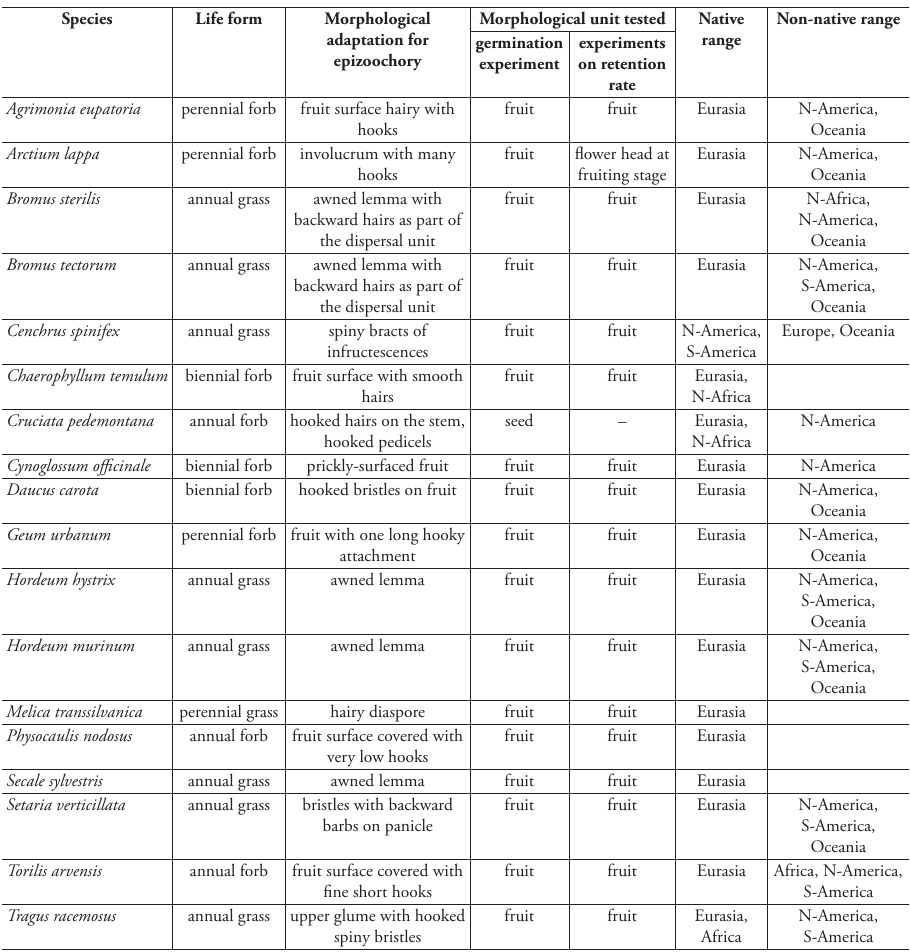
Table 1. Characteristics of the studied 18 species. Native and non-native ranges are given based on the CABI Invasive Species Compendium (https://www.cabi.org/isc/) and the EPPO Global Database